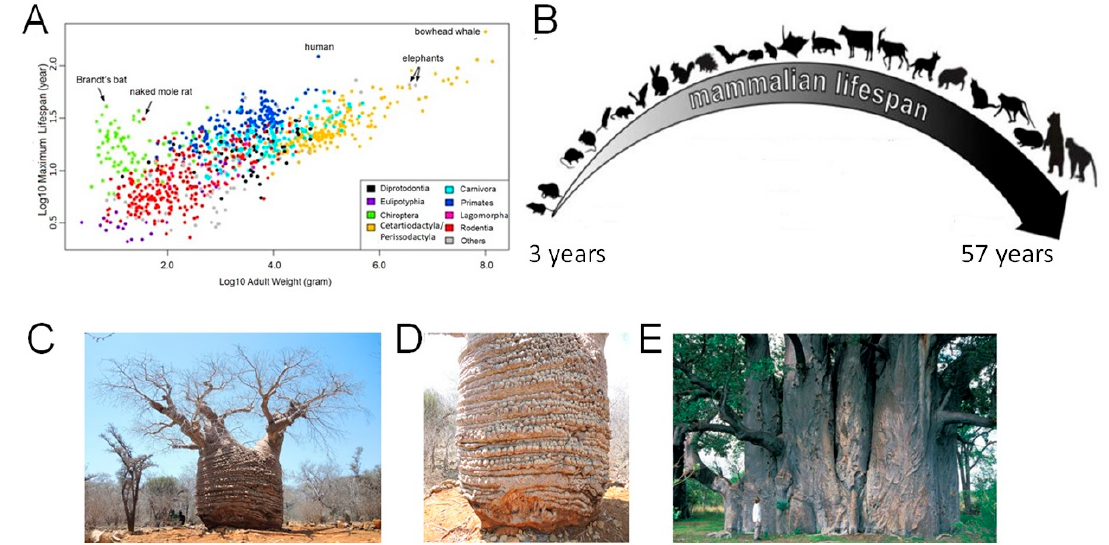
Figure 1. Lifespan variation across different species. ( A ) There is a positive correlation between the lifespan and weight of adult mammals [2]. Data for adult body mass and maximum lifespan records of mammalian species are from an age database [6]. ( B ) Shrews such as the Suncus etruscus is a small and short-lived species which weighs approximately two grams and has a lifespan of nearly 3.2 years. The other extreme are the large and long-lived animals: African elephant ( Loxodonta africana ) is the largest land mammal with an average weight of six tons and a lifespan of seventy years. The lifespan of plants is considerably longer than animals. The ages of some trees is well over 1,000 years. ( C ) The general view of the oldest baobab of Madagascar Adansonia rubrostipa (fony baobab). ( D) Tri-stemmed trunk of the Grandmothers baobab with bulbous formations. ( E ) The southern flank of Grootboom, the largest known African baobab. Early African explorers attempted to extrapolate the low growth rate of old baobabs over their entire lifecycle, claiming their age to be up to 5,150 years for the largest individuals [7,8]. A,B—modified from [2]; C,D—from [7], E—from [9].